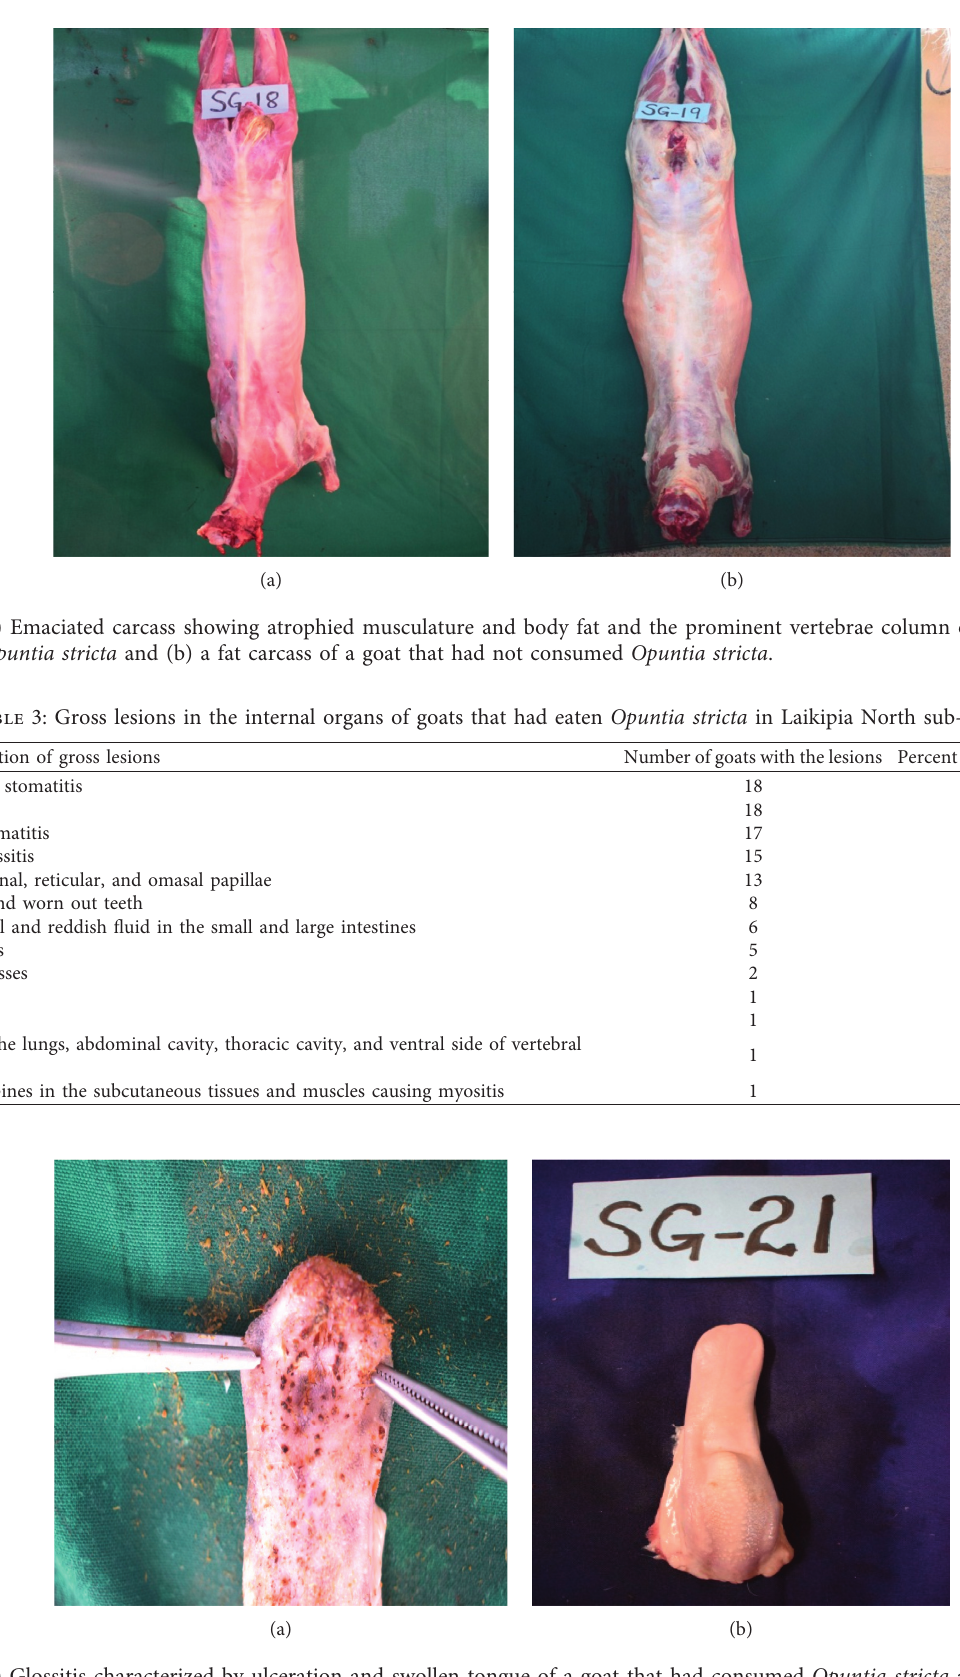
Figure 7: (a) Glossitis characterized by ulceration and swollen tongue of a goat that had consumed Opuntia stricta and (b) a healthy- appearing tongue of a goat that had not consumed Opuntia stricta